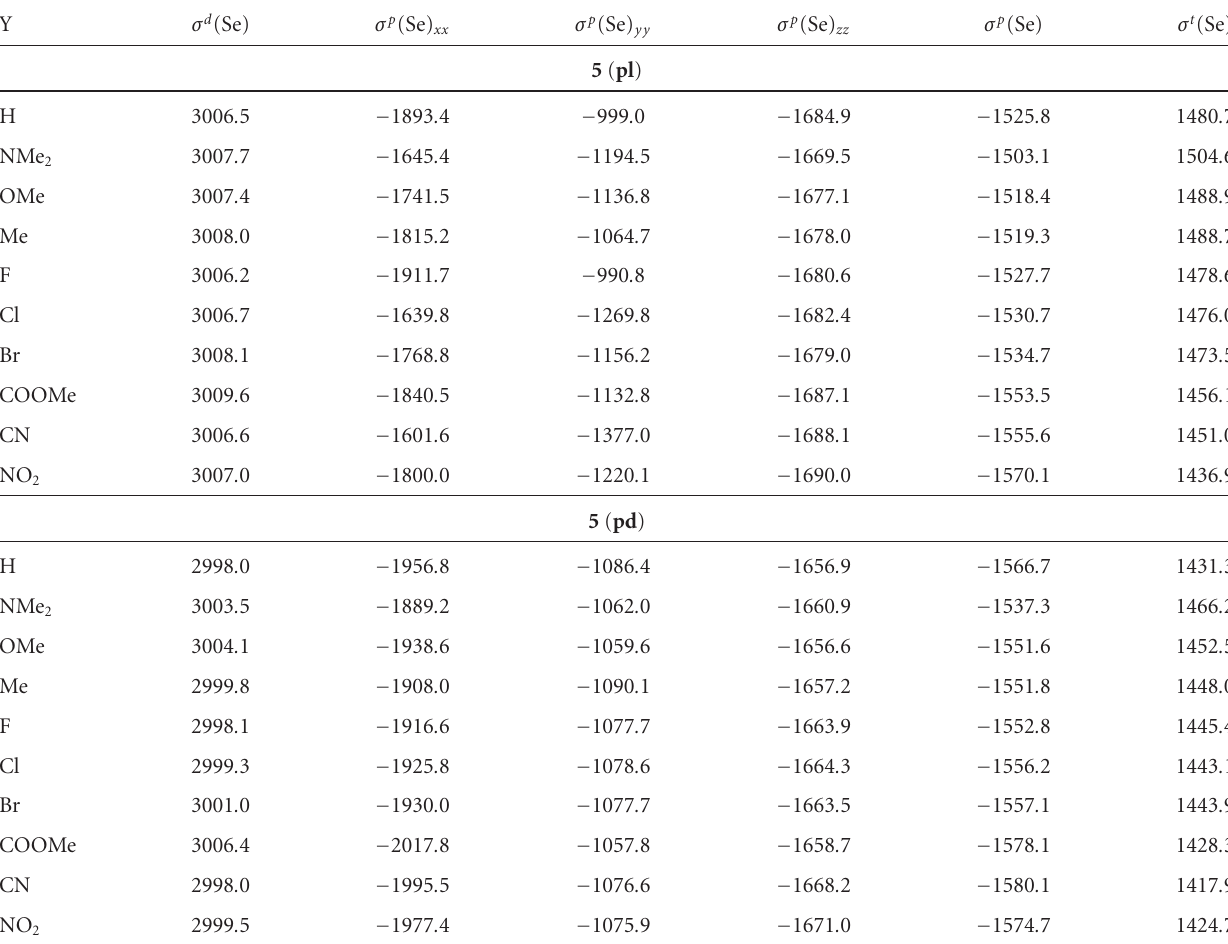
Table 4: Calculated absolute shielding tensors ( σ (Se)) of 5 , containing various Y (a)